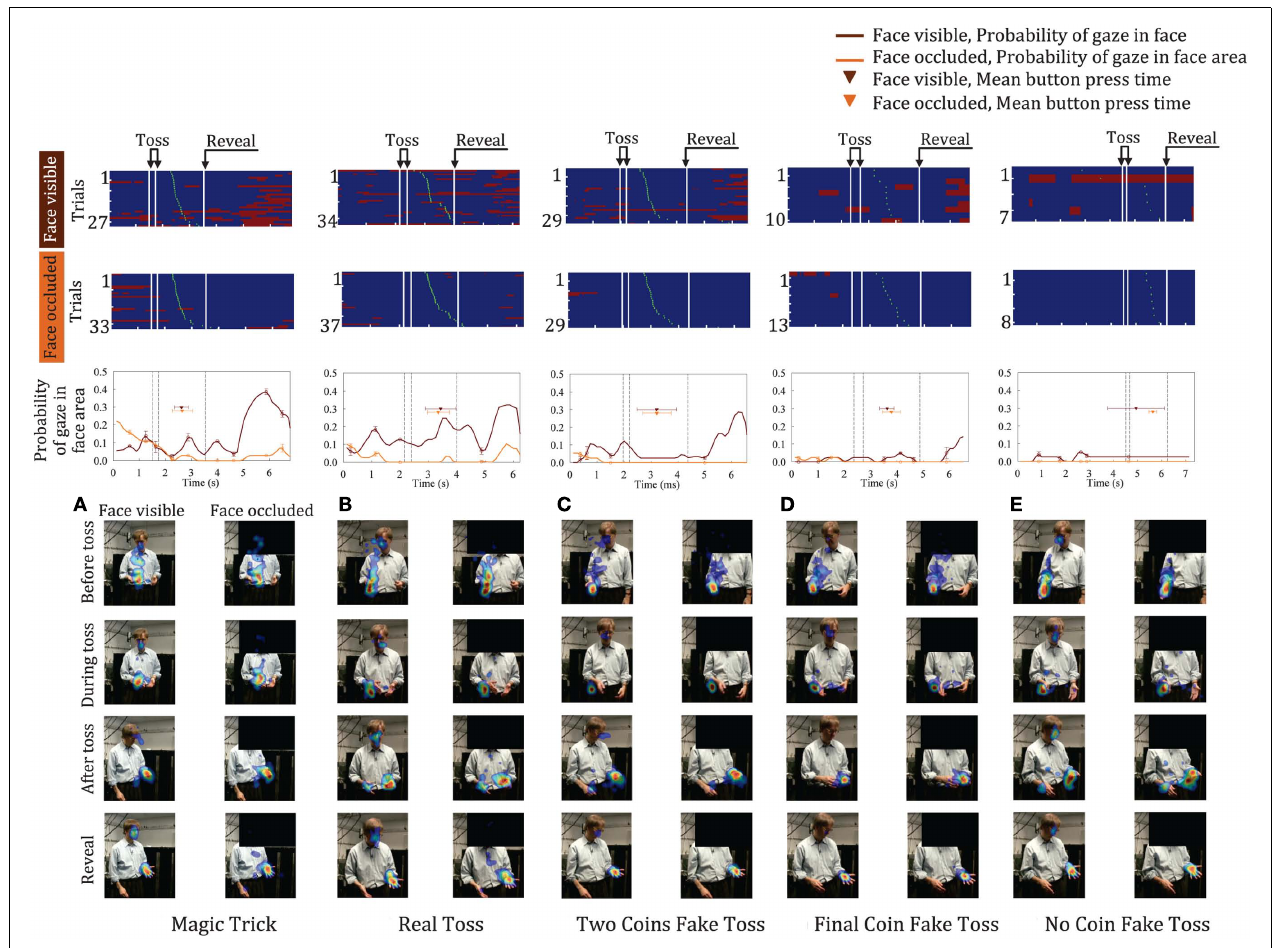
fastest to slowest.The brown and orange lines illustrate the probability with which the subjects’ gaze fell on the magician’s face area; the brown and orange triangles indicate the mean time of button presses.The small circles on the lines indicating probability of gaze in the face area represent the selected time locations for error bar calculation. Error bars indicate one SD. The lower section of each panel represents the spatial distribution of the subjects’ gaze for each experimental condition.The hotter the color, the higher the probability that the subjects’ gaze was located in that